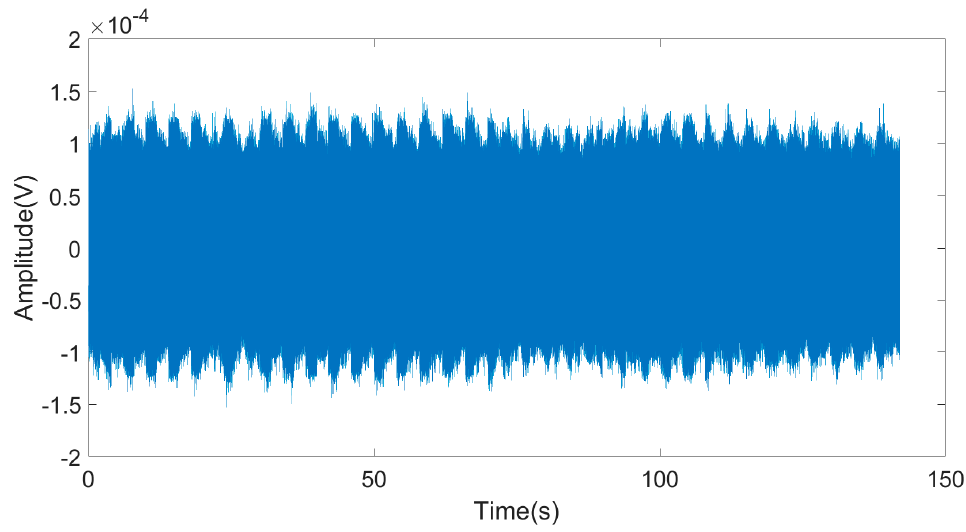
Figure 10. The raw received signal with directional antennas.